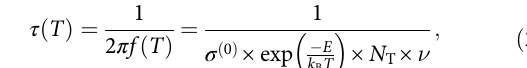
Fig. 2 Structure and energy diagram of MoS 2 monolayer sample. a Illustration of MoS 2 lattice structure, with a sulfur monovacancy; top view, side view. Theoretical work has shown the spatial extent of the vacancy ’ s electronic orbitals to be ~2 unit cells 10,32 . b Schematic bandstructure diagram of the sample. The presence of a vacancy defect V S leads to the formation of mid-gap states ( a 1 , e ) (refs. 9,10,20 ). Here the con fi guration V S ( − 1) is shown. The Fermi level E F lies within the MoS 2 energy bandgap; since in our sample geometry, MoS 2 is in contact with a gold substrate, position close to the conduction band minimum E C . c Schematic stability diagram of the charge states in monolayer MoS 2 , as a function of E F (adapted from refs. 10,11 ). d Bottom: electron con fi gurations of V S , in the charge states 0, − 1, and − 2. Top: schematic energy diagram of these V S charge states constructed from our experimental observations. Electron capture/detrapping events result in switching between discrete states, V S (0) ↔ V S ( − 1) and V S ( − 1) ↔ V S ( − 2). The energy barriers E β and E α determine the degree of meta-stability of V S (0) and V S ( − 2), respectively. E V , valence band